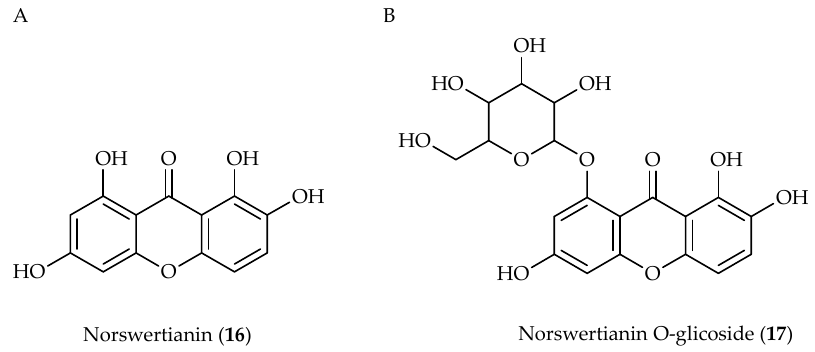
Figure 8. Chemical structure of Norswertanin ( 16 ) and Norswertianin O -glicoside.